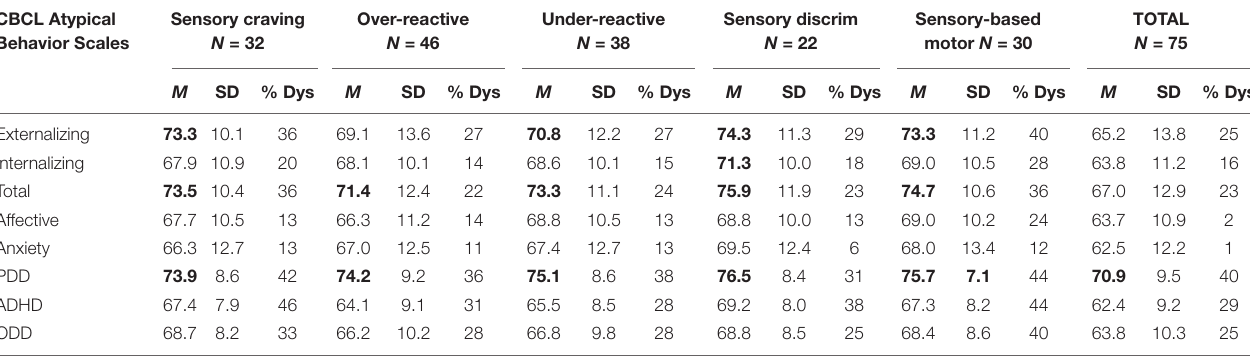
TABLE 1 | Child Behavior Checklist T-scores by sensory processing disorder type. CBCL Atypical Behavior Scales